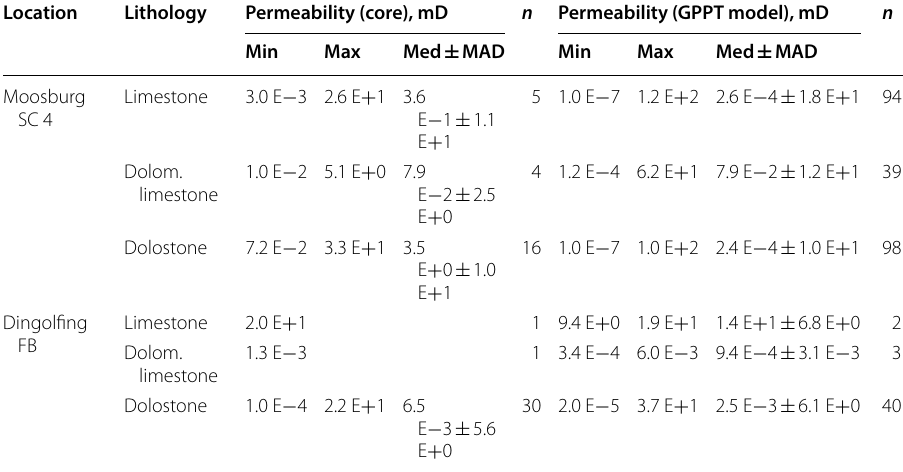
Min minimum, Max maximum, Med median, MAD median absolute deviation, n count